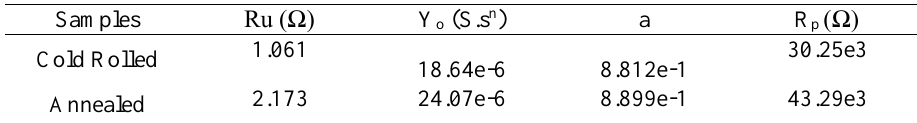
Fig. 5. The equivalent circuit models for EIS data fitting. Table 4. Fitting Results of Electrical Elements for Cold Rolled Alloy and 50°C